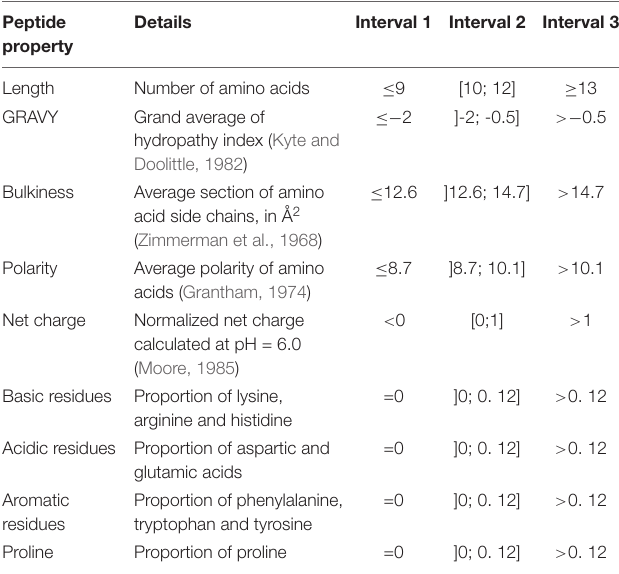
TABLE 1 | Peptide physicochemical properties and interval division used for peptide